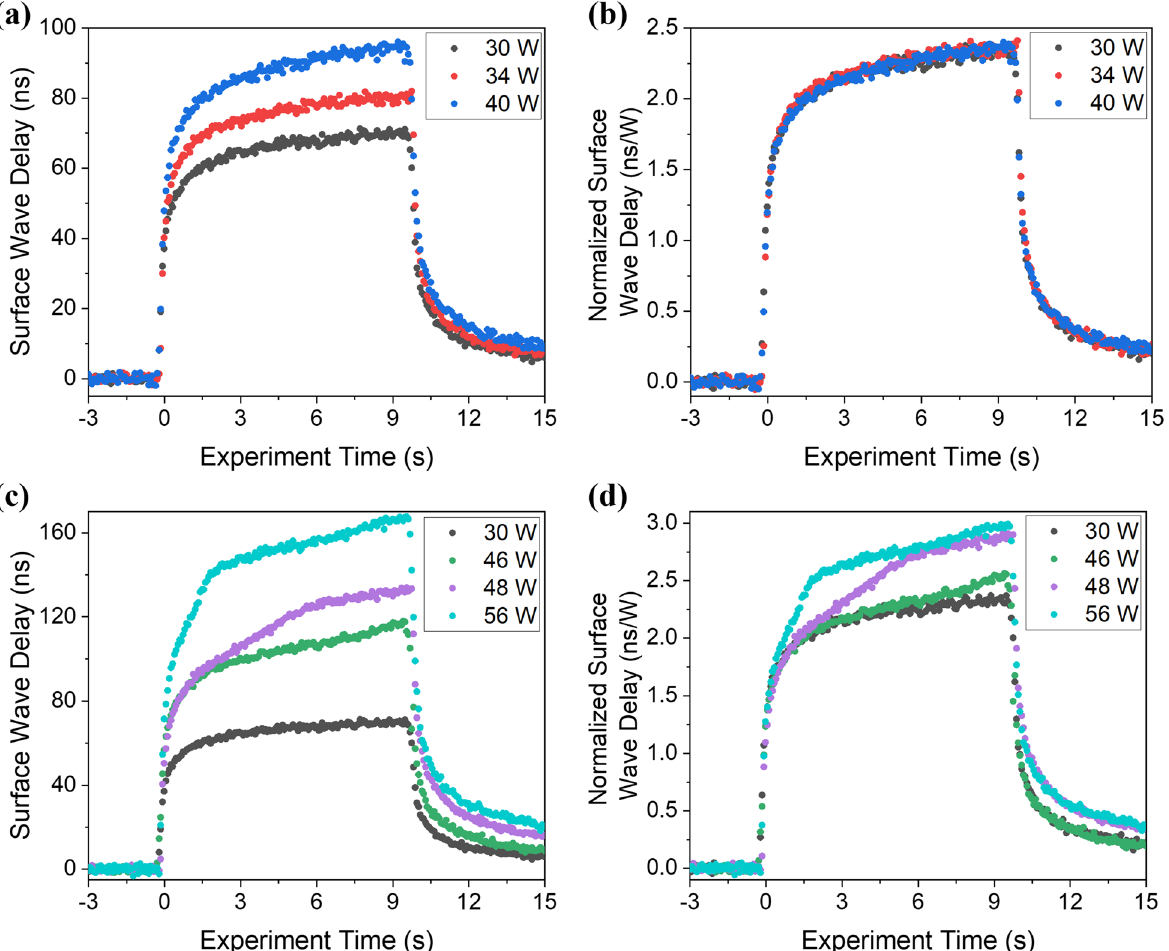
Figure 6. ( a ) Real-time transient surface wave delays and ( b ) normalized surface wave delays, in units of ns/W, for heating powers of 30, 34, and 40 W. ( c ) Real-time transient surface wave delays and ( d ) normalized surface wave delays for heating laser powers of 30, 46, 48, and 56